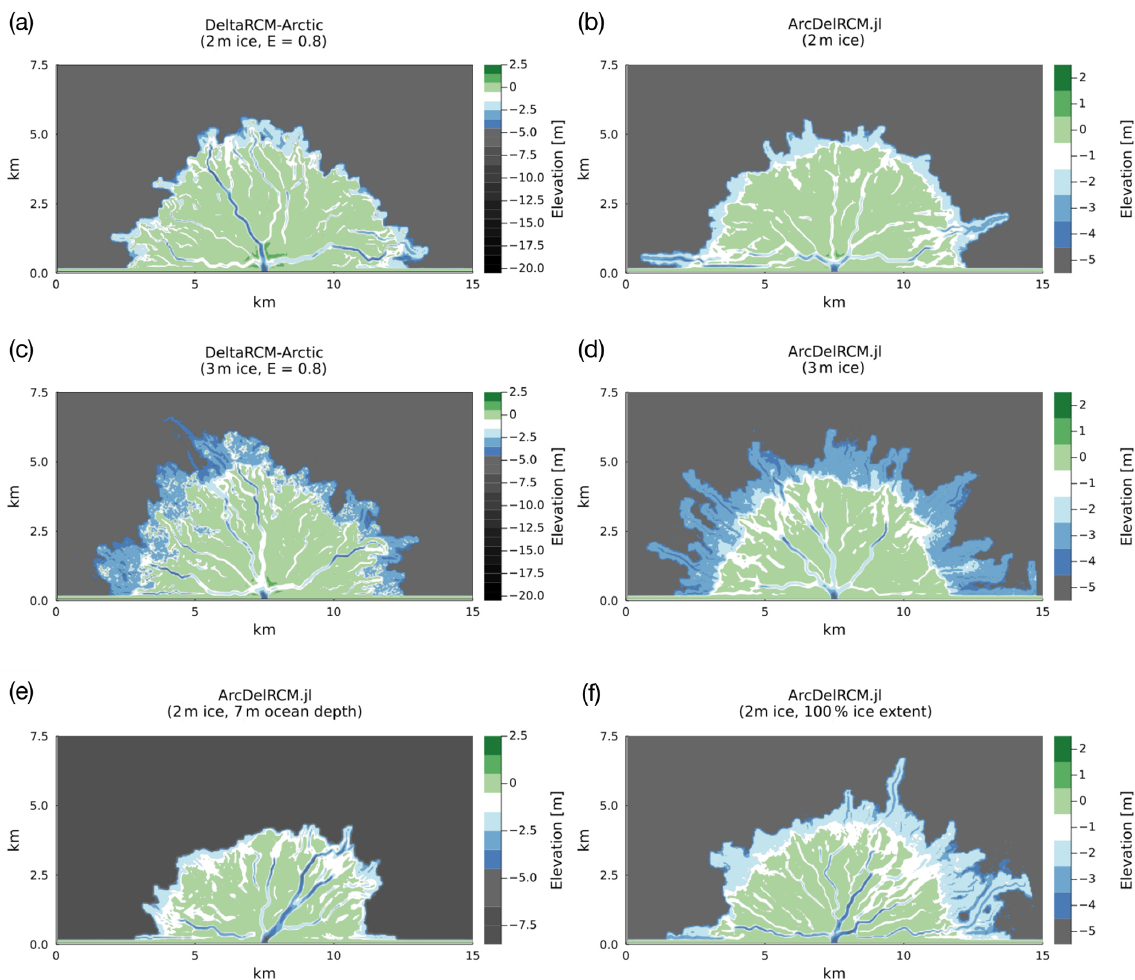
Figure 4. Bed-elevation output of (a, c) DeltaRCM-Arctic and (b, d–f) ArcDelRCM.jl after 5000 time steps (following a 300-step lead-up un- der non-Arctic conditions). All runs have identical parameters (see text for full configuration), except the following differences: (a, b) h ice , max is 2m; (c, d) h ice , max is 3m; (e) h B is 7m; and (f) the ice extent is 100%. Note the depths of the ramp features in panels (b) and (d) , which correspond to h ice , max . Tentacle-like “offshore depositions” (as described in Piliouras et al., 2021) are visible in the h ice , max = 3m cases of DeltaRCM-Arctic (in panel c ) as well as outside the ramp of ArcDelRCM.jl (in panel d ). Also, the ramp feature has vanished in panel (e) but has become more prominent in panel (f)